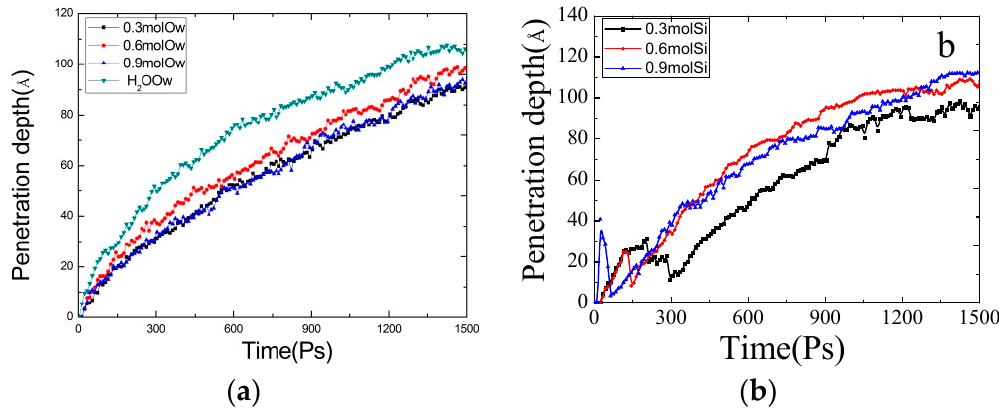
Figure 4. Penetration depth of ( a ) four different models of water molecules, and ( b ) three different models of siloxane molecules.